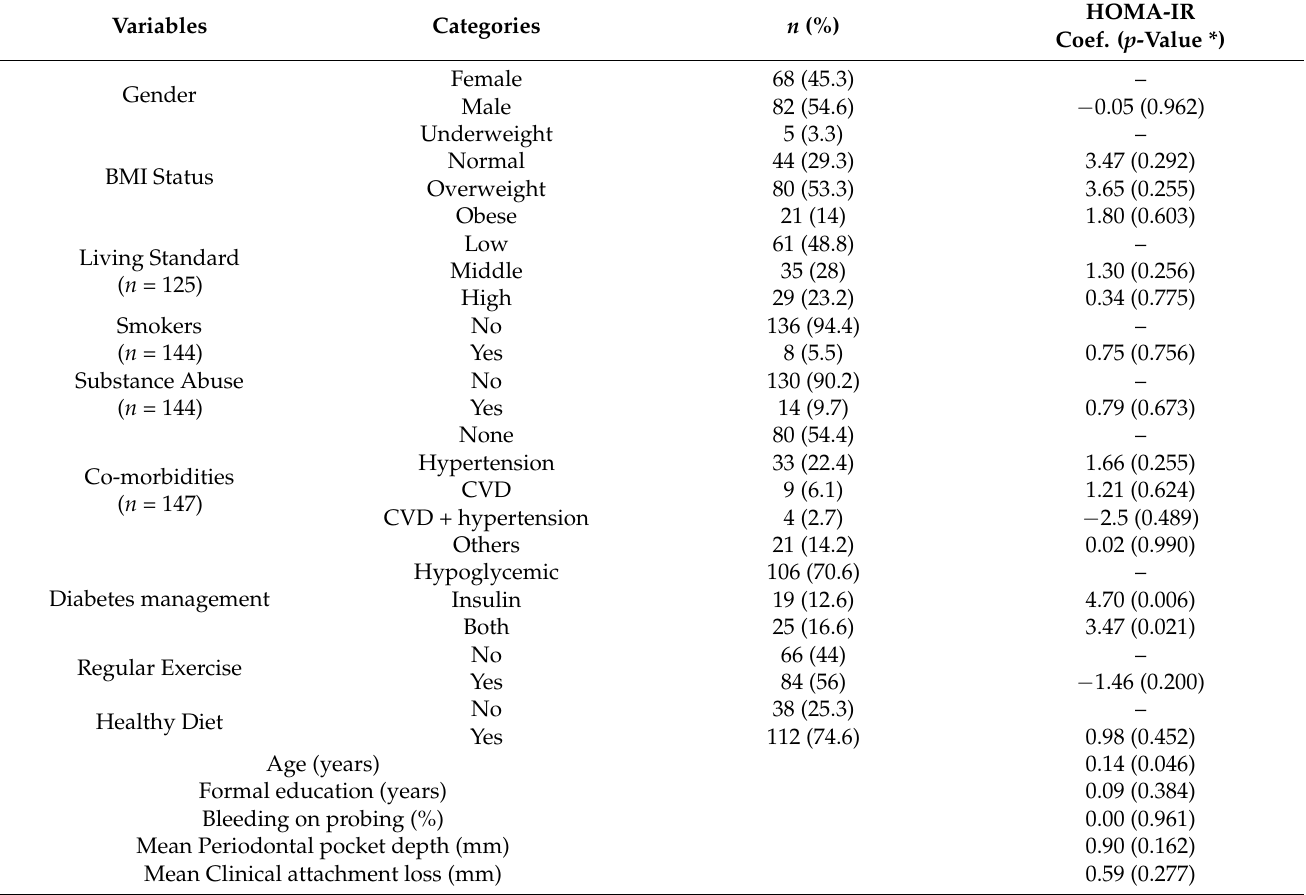
Table 1. Baseline characteristics (categorical) of participants before allocation [ n = 150].